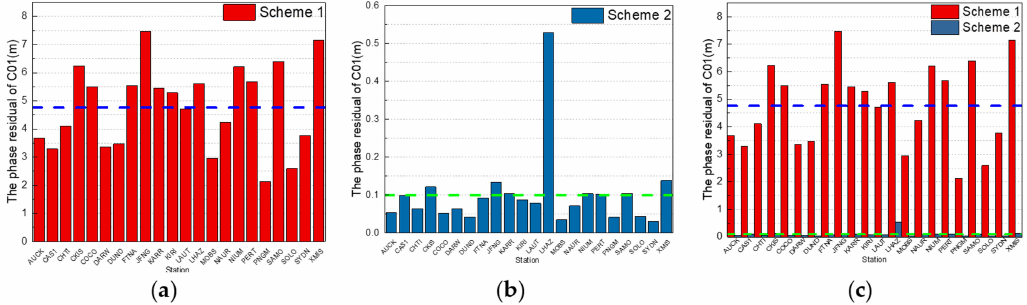
Figure 2. Phase residuals of stations for C01 in the first adjustment for data processing on 9 January 2017: residuals from precise orbit determination according to ( a ) scheme 1 and ( b ) scheme 2 and ( c ) comparison between Figure